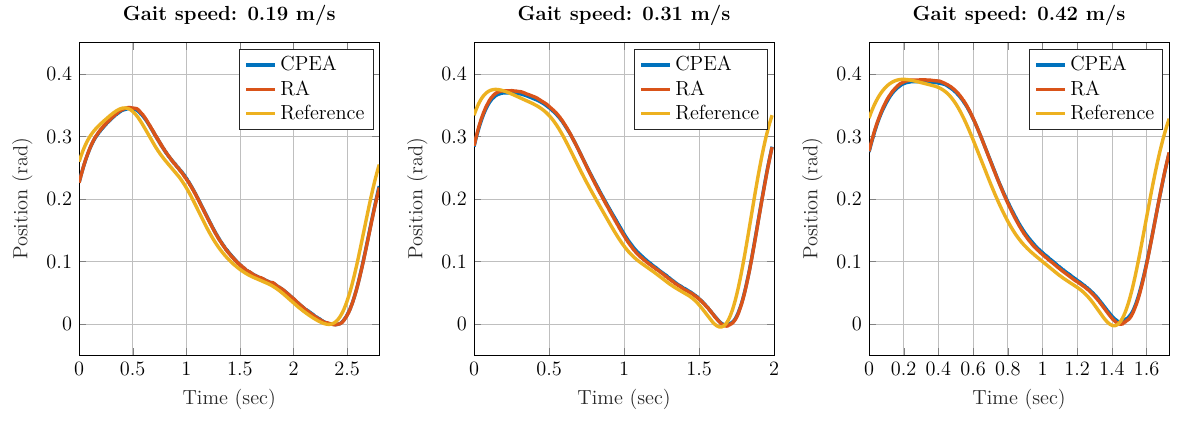
Figure 13. Angular position for the hip joint at three different gait velocities for an RA and